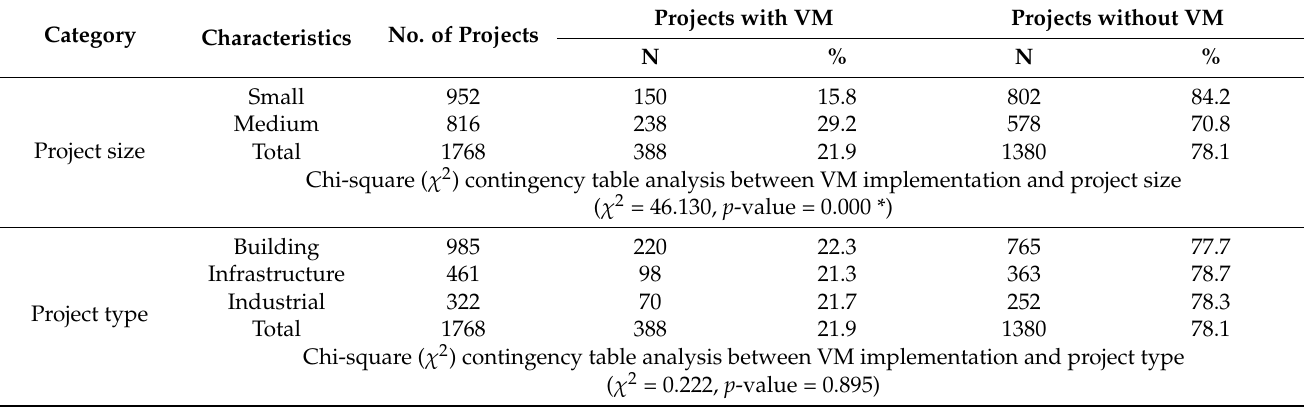
Table 4. Status of VM implementation: project